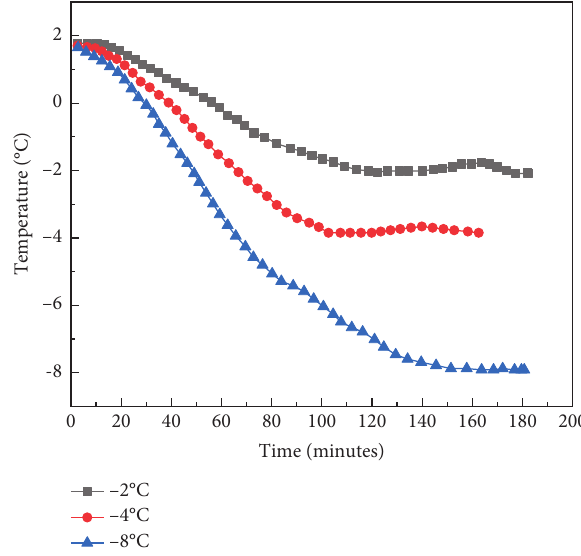
Figure 6: Temperature change of cold